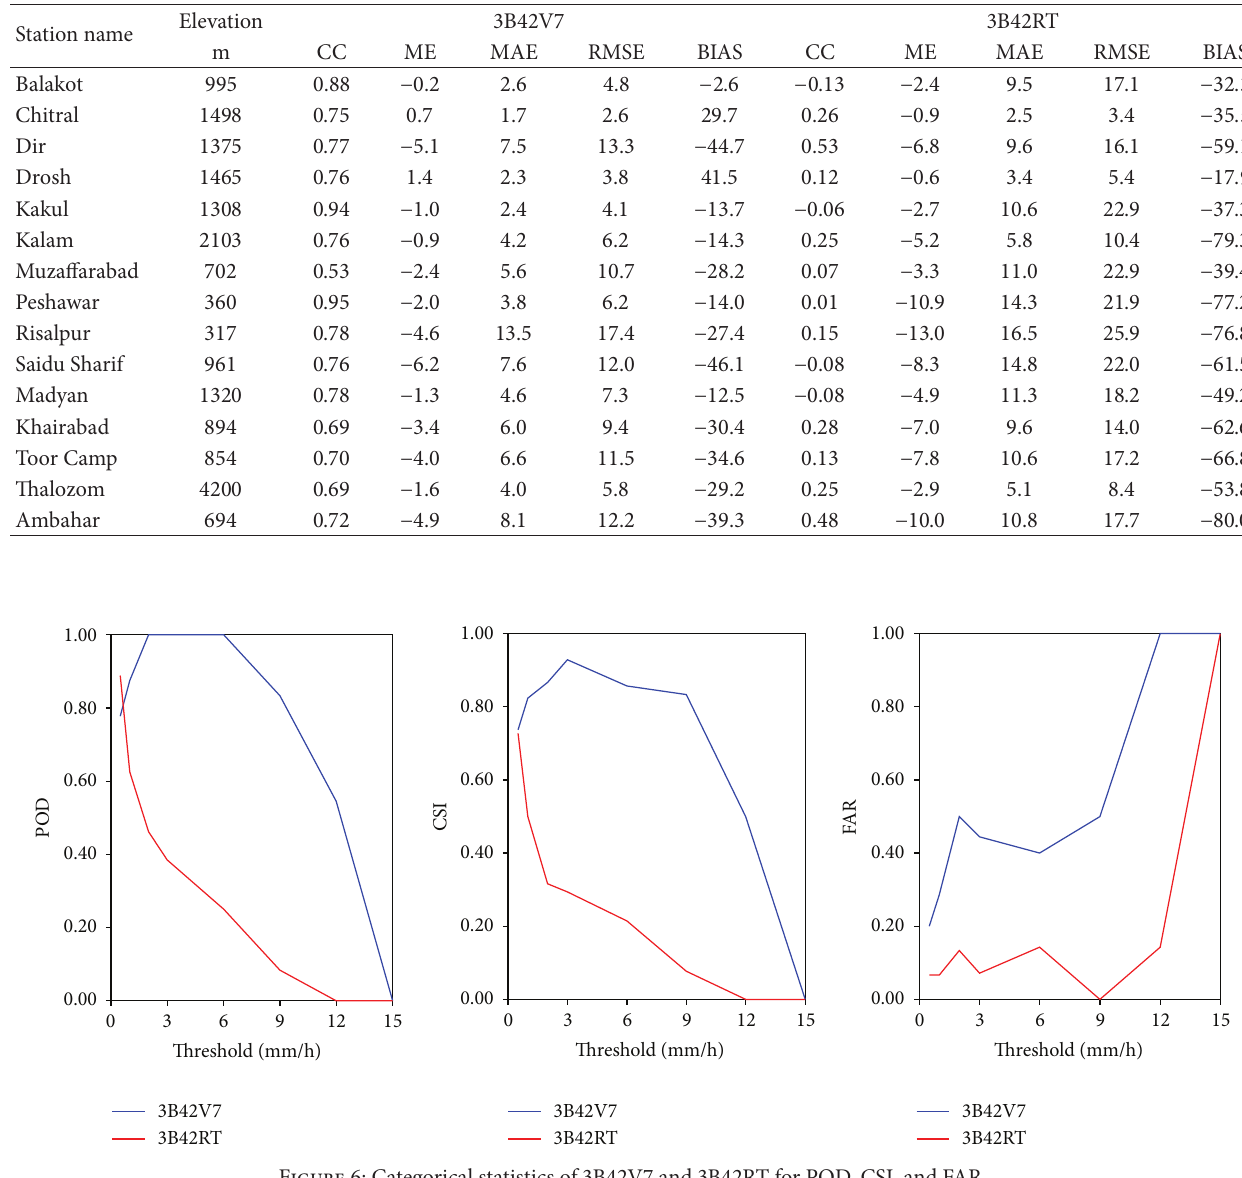
Table 1: Statistics of satellite precipitation products for 28–30 July 2010 precipitation.